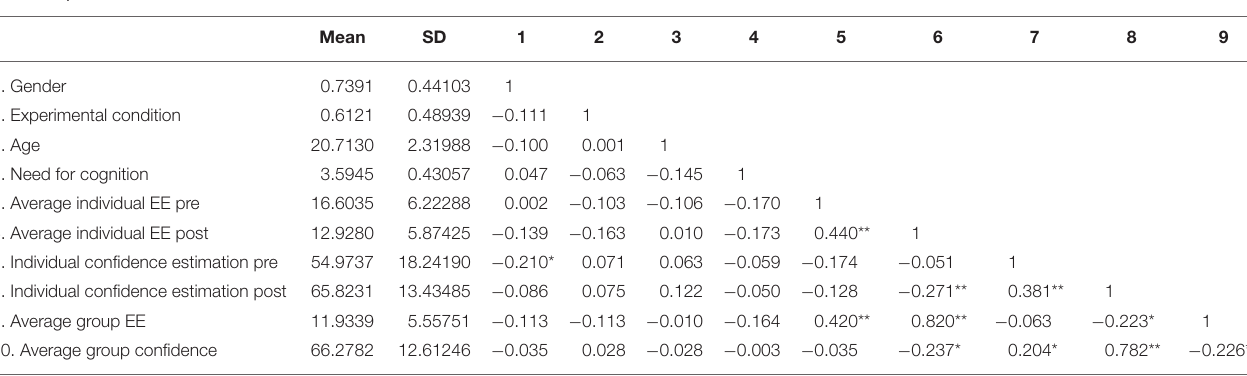
TABLE 1 | Means, standard deviations, and correlations.